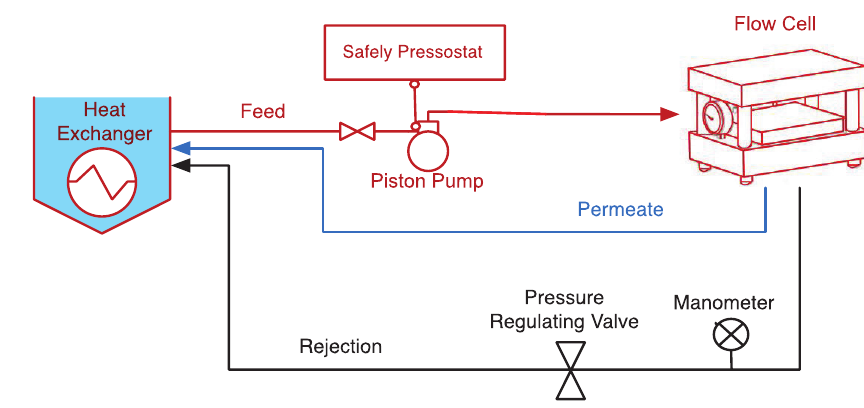
Fig. 2 – Flow cell process scheme Fig. 2 Flow cell process scheme